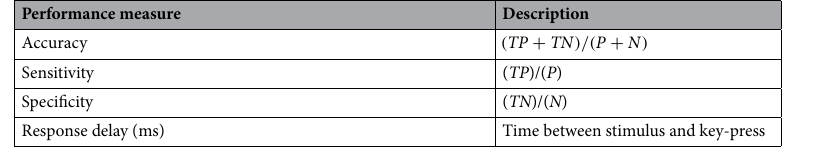
Table 1. Visuospatial two-back task performance metrics. TP = T rue P ositives; P = all P ositive or response selection events. TN = T rue N egatives; N = all N egative or response inhibition events.